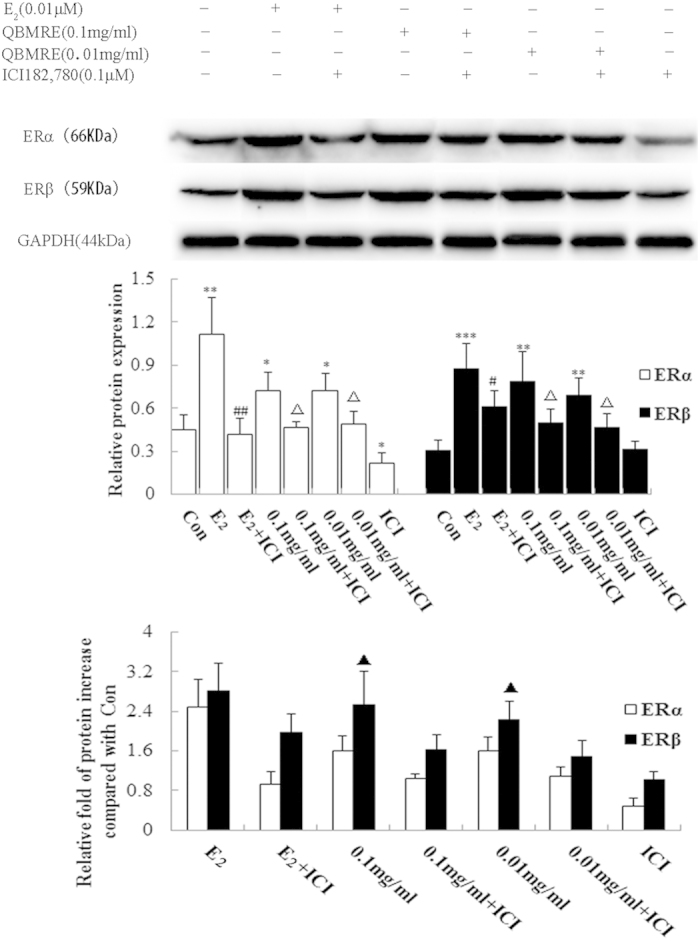
Estrogen receptor α (ER α) and ERβ expression in MCF-7 cells.Western blot analysis of ER subtype expression in MCF-7 cells was carried out as described in the Materials and Methods. *p < 0.05, compared to DMSO; #p < 0.05, ##p < 0.01, compared to 0.01 μM E2; (△) p < 0.05, compared to QBMRE. (▲) p < 0.05, compared with ERα protein relative increase to Control.